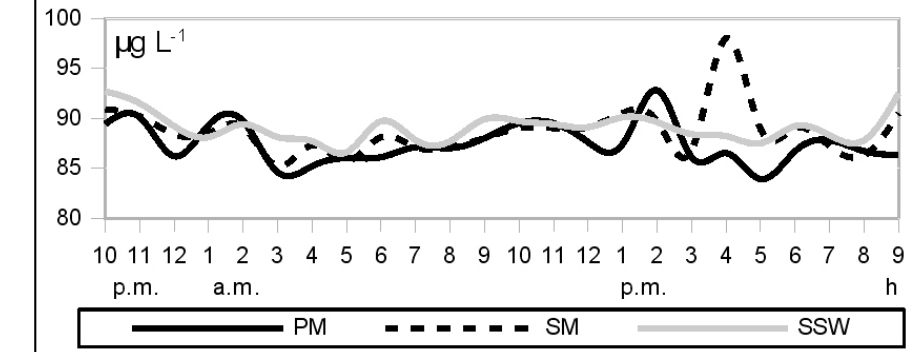
Figure 5. Diurnal variation in the conductivity (mS) in surface microlayers and subsurface water of Lake Dołgie Wielkie.